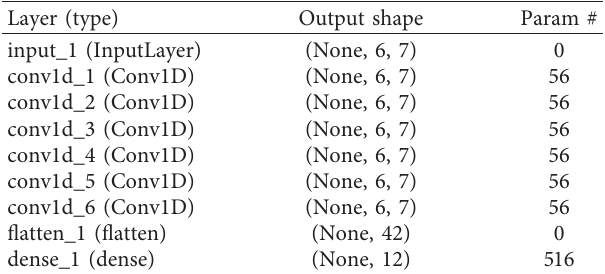
Table 6: CNN network structure.